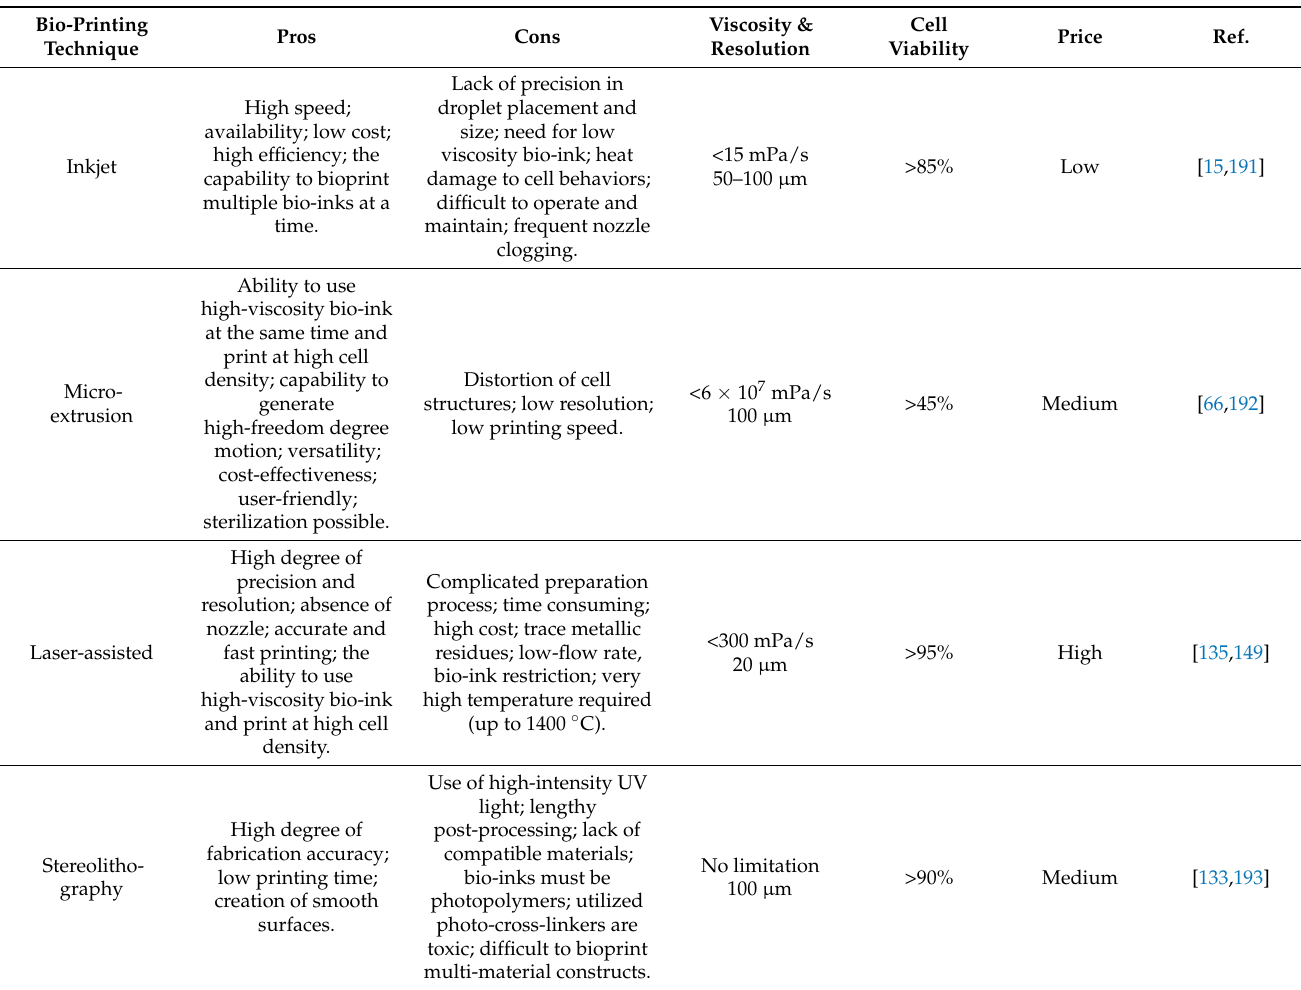
Table 2. Overview of pros and cons of common techniques in 3D bioprinting